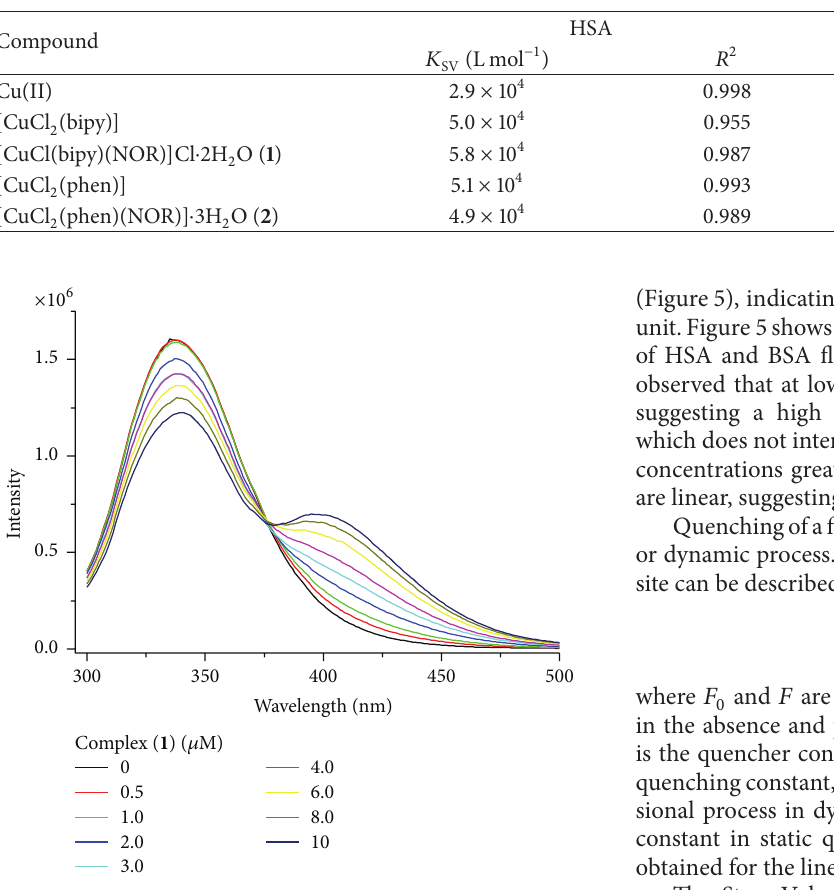
not contain molecular information. The fluorescence